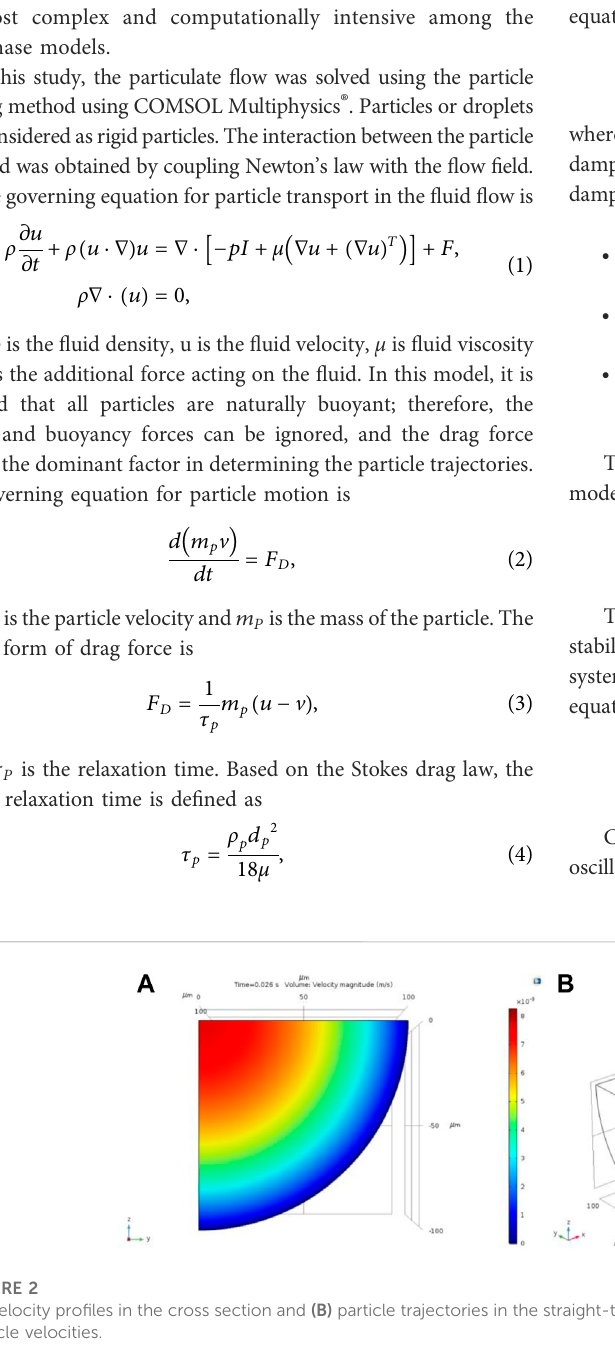
Frontiers in Earth